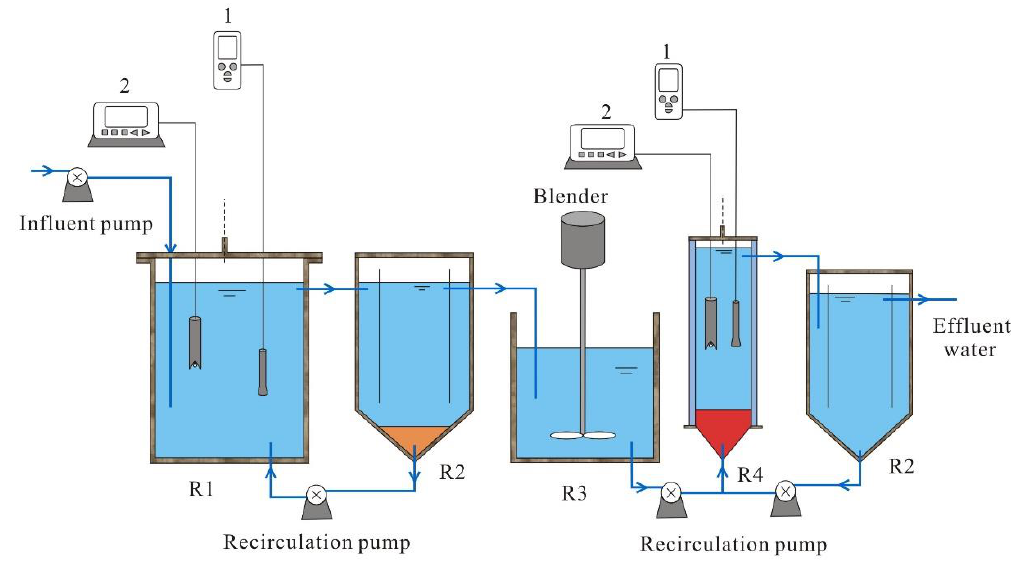
Figure 1. Schematic of experimental setup. Influent pump, influent water pump; recirculation pump, reflux water pump; R1, partial nitrification reactor; R2, sedimentation / adjustment tank; R3, transfer tank; R4, anammox reactor; 1, pH online monitoring; 2, DO online monitoring.